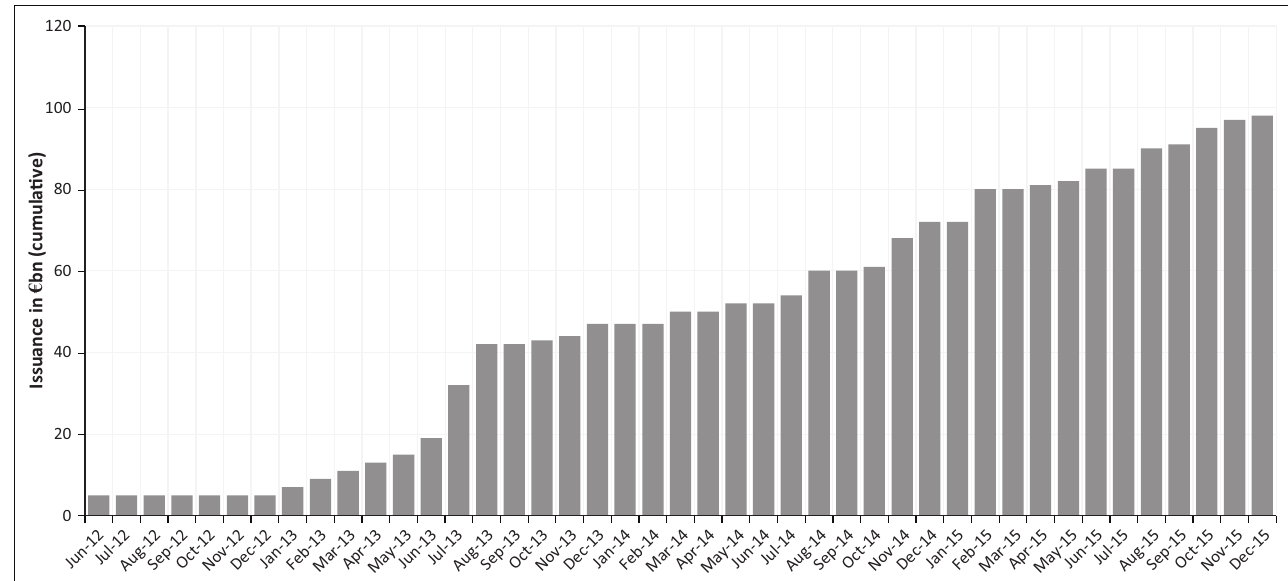
FIGURE 4: Total global contingent convertibles issuance (to end